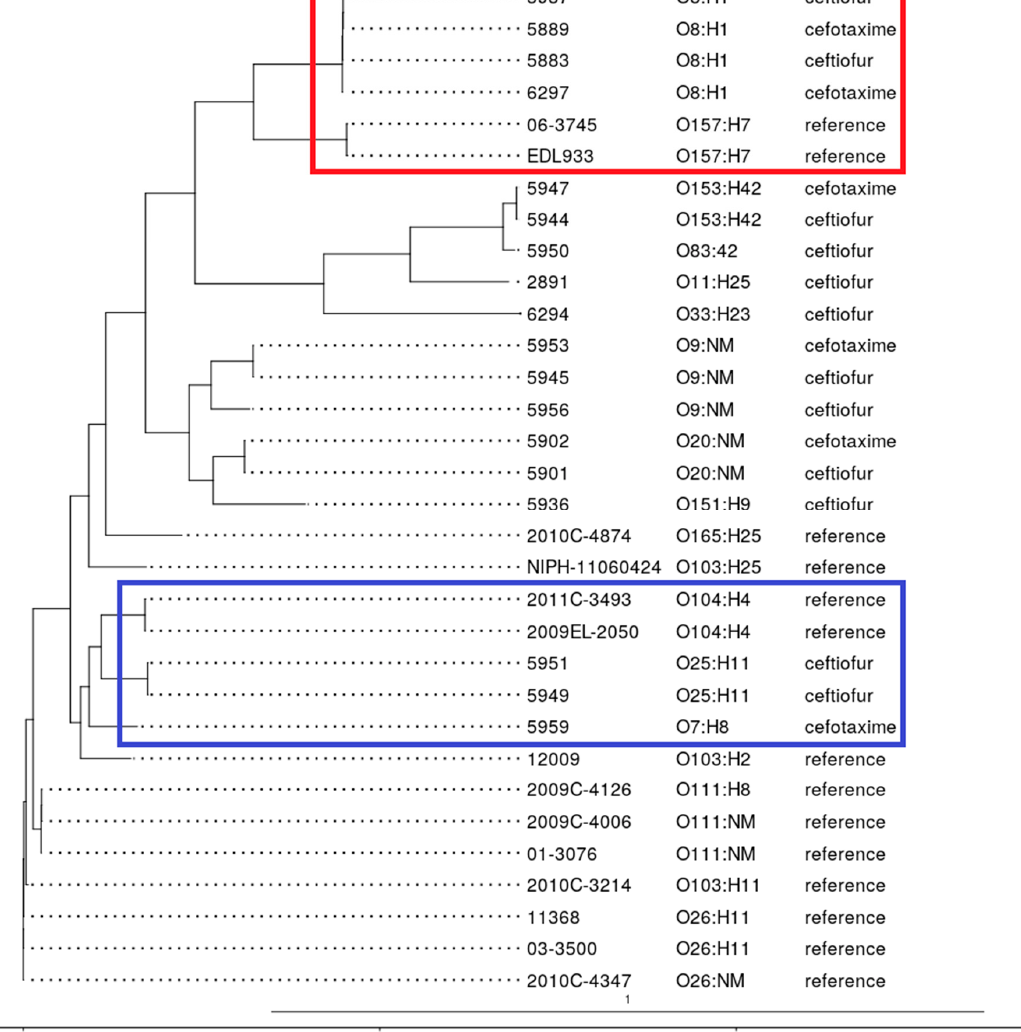
Figure 7. Genome-wide phylogenetic tree produced in PhyML using the “Generalized Time Reversible” model of nucleotide substitution showing the relationship among 18 E. coli isolates (of 10 different serotypes) recovered from dairy cow manure and their comparison with 14 reference genomes. The red and blue box show related strains. The scale is number of substitutions per site.